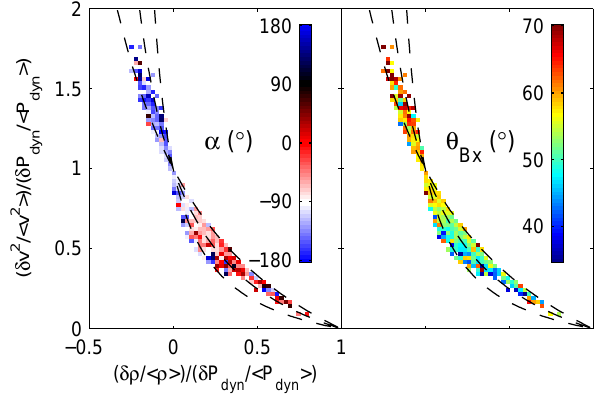
Fig. 4. Variation of the IMF clock angle α (left) and acute cone angle θ Bx (right), for dynamic pressure enhancements, in the same format as Fig.